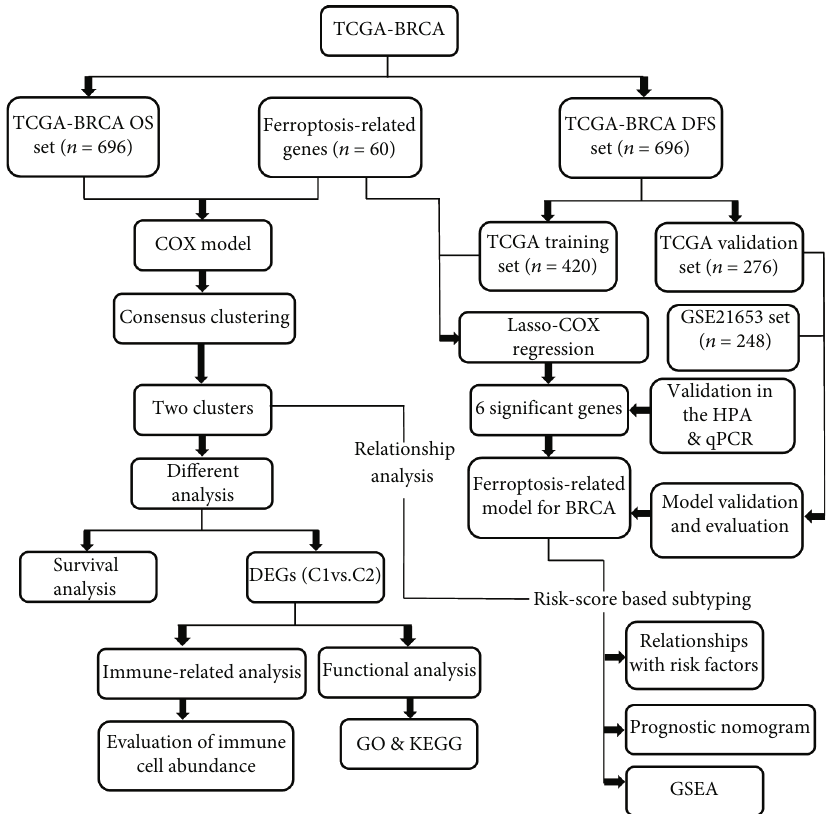
Figure 1: Flowchart of the data collection and